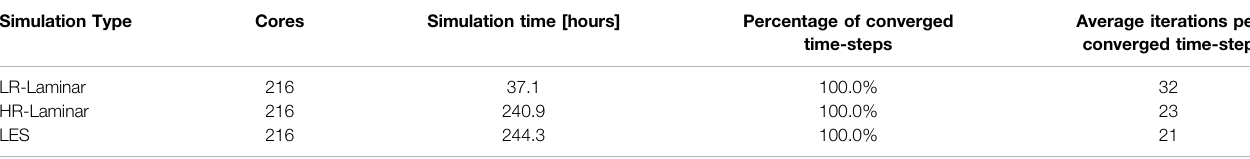
TABLE 3 | Simulation times and convergence details.